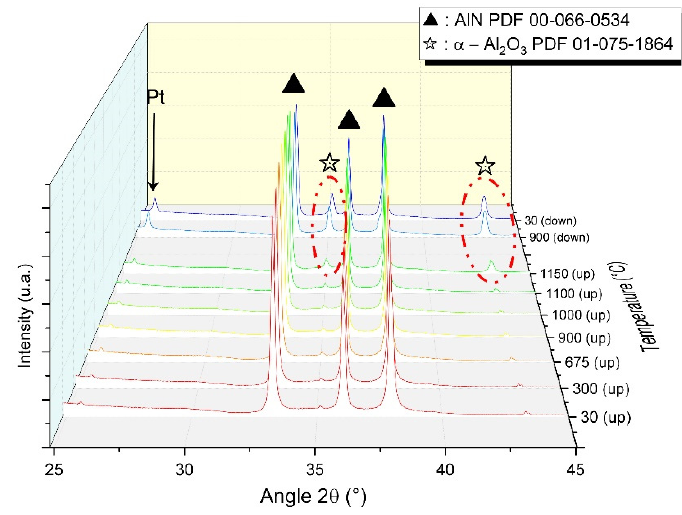
Figure 5. X-ray diffraction patterns of aluminum nitride (AlN) powder during in situ thermal treatment under N 2 atmosphere.